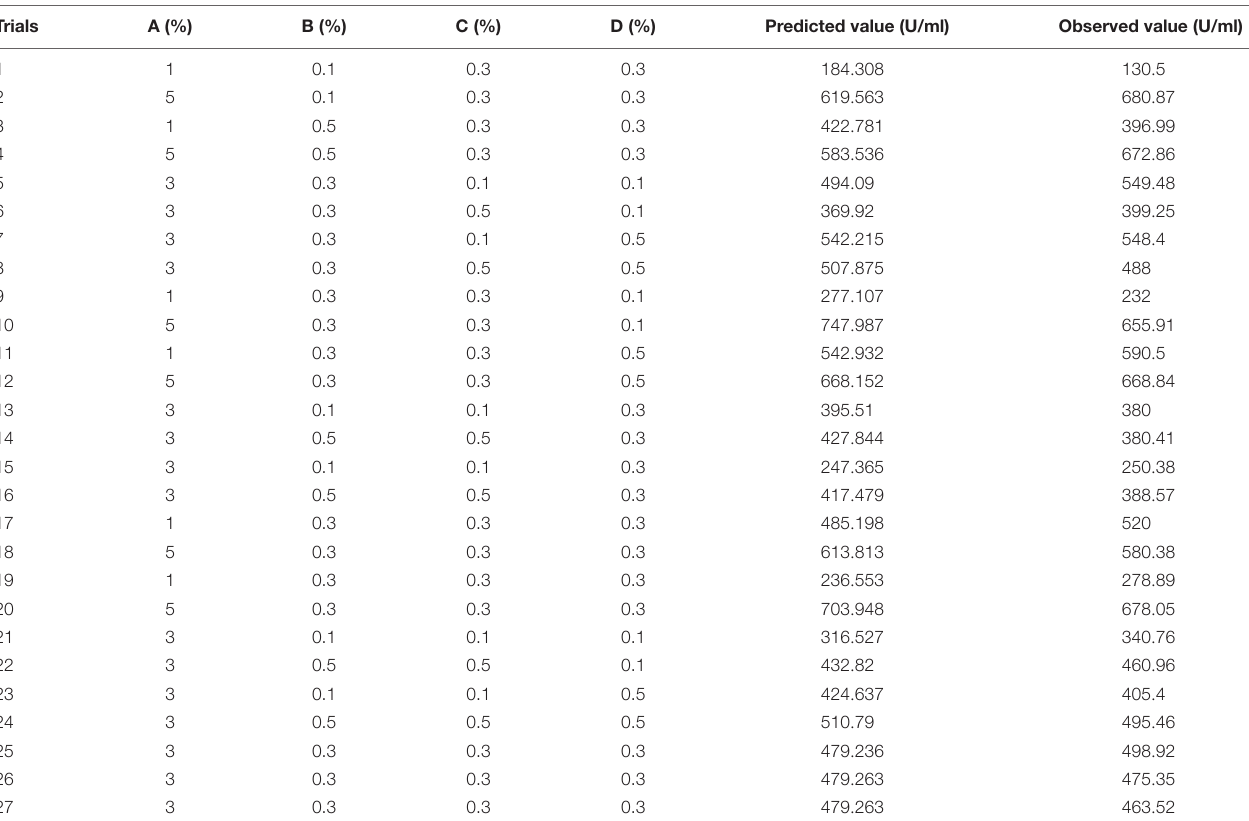
TABLE 2 | Results of Box Bekhman using four independent variables and three center points showing predicted and observed response of protease production by B. pumilus MP 27 under submerged fermentation.